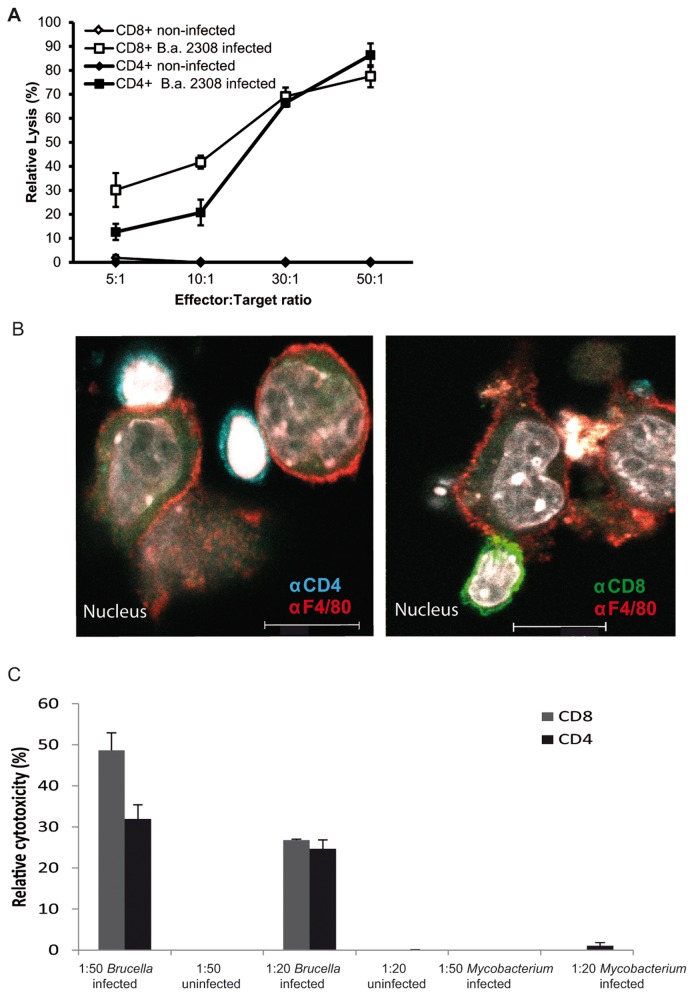
Cytolytic capacity of Granzyme B+CD4+T cells.Lysis of non-infected and B. abortus-infected macrophages in the presence of CD4+ and CD8+ T cells isolated from the spleens of BALB/c mice infected for 8 days with Brucella was analysed. Macrophage targets and effector cells were mixed at several effector:target /T ratios and incubated for 4 h. Values given represent relative macrophage lysis as compared to a Tx-100 treated 100% control (A). Parallel samples of heat-killed B. abortus-infected Raw macrophages on coverslips were processed for immunofluorescence microscopy. Representative micrographs show macrophages after 4 h of coculture with CD8+ or CD4+ effector cells (B). (C) Lysis of non-infected, B. abortus-infected and M. avium-infected macrophages in the presence of CD4+ and CD8+ T cells isolated from the spleens of BALB/c mice infected for 8 days with Brucella was analysed. Macrophage targets and effector cells were mixed at 1:50 and 1:20 target:effector ratios and incubated for 4 h. Values given represent relative macrophage lysis as compared to a Tx-100 treated 100% control.